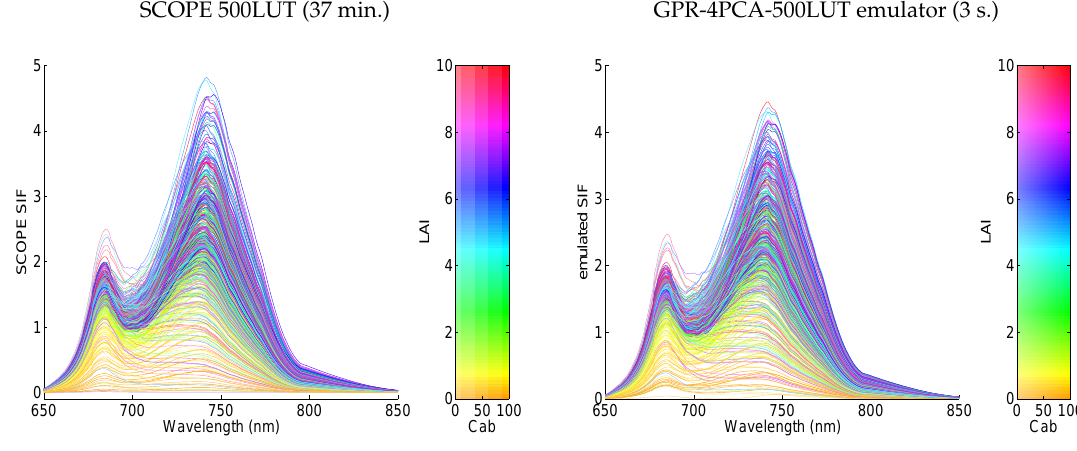
Figure 9. Left : 500 original SCOPE SIF spectra. Right : 500 emulated SIF spectra as generated by the SCOPE500 GPR-4PCA emulator. Processing time for the generation of the 500 LUT is added on top.